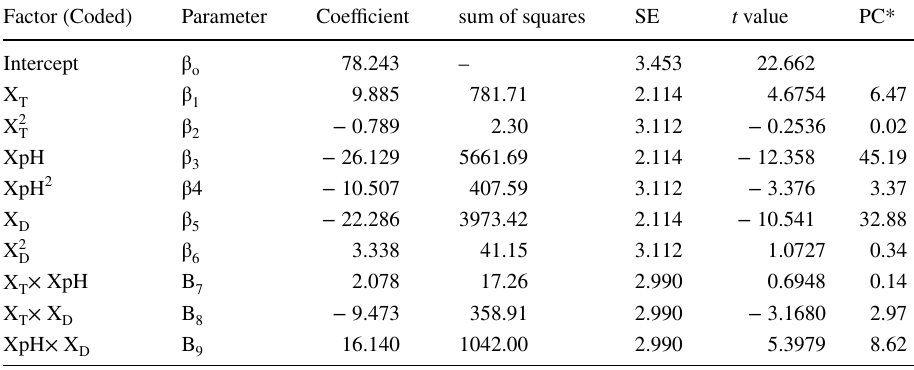
Table 4 Multiple regression results and significance of the components for the quadratic model